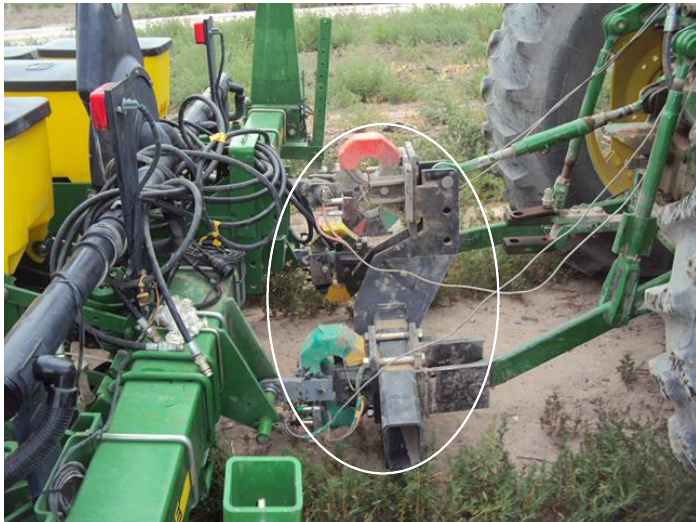
Figure 1. An integrated dynamometer for mounted implements (circled) attached to the three-point linkage. The implements are coupled to the dynamometer.